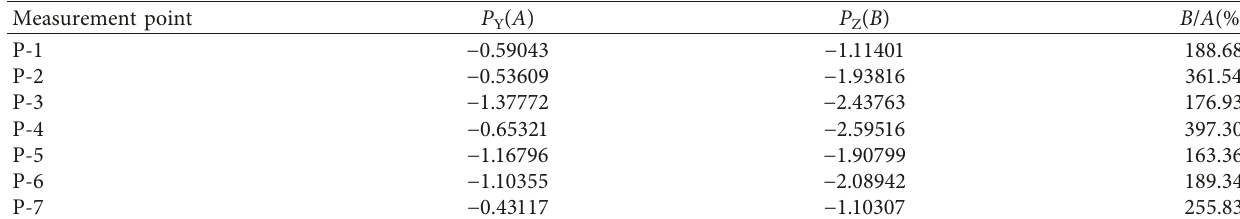
Table 5: Compressive stresses at measurement points of the middle partition wall